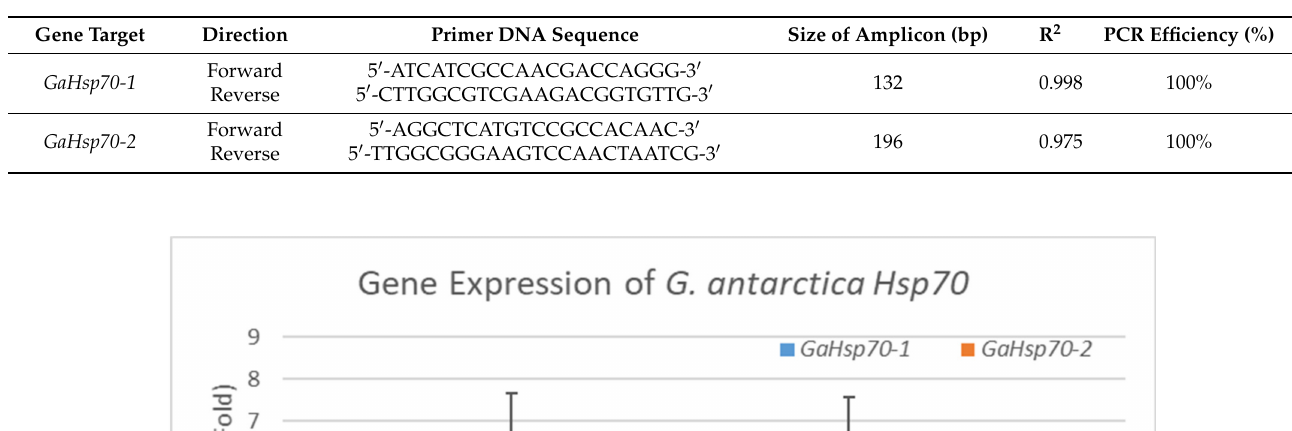
Table 1. Primers used for rt-PCR.